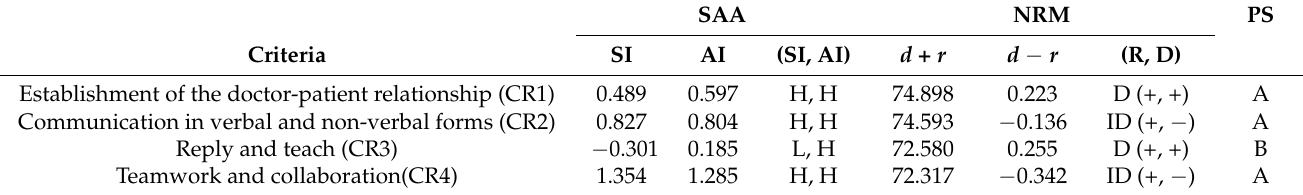
Table 12. The development strategies of the communication and relationship (CR) aspect.